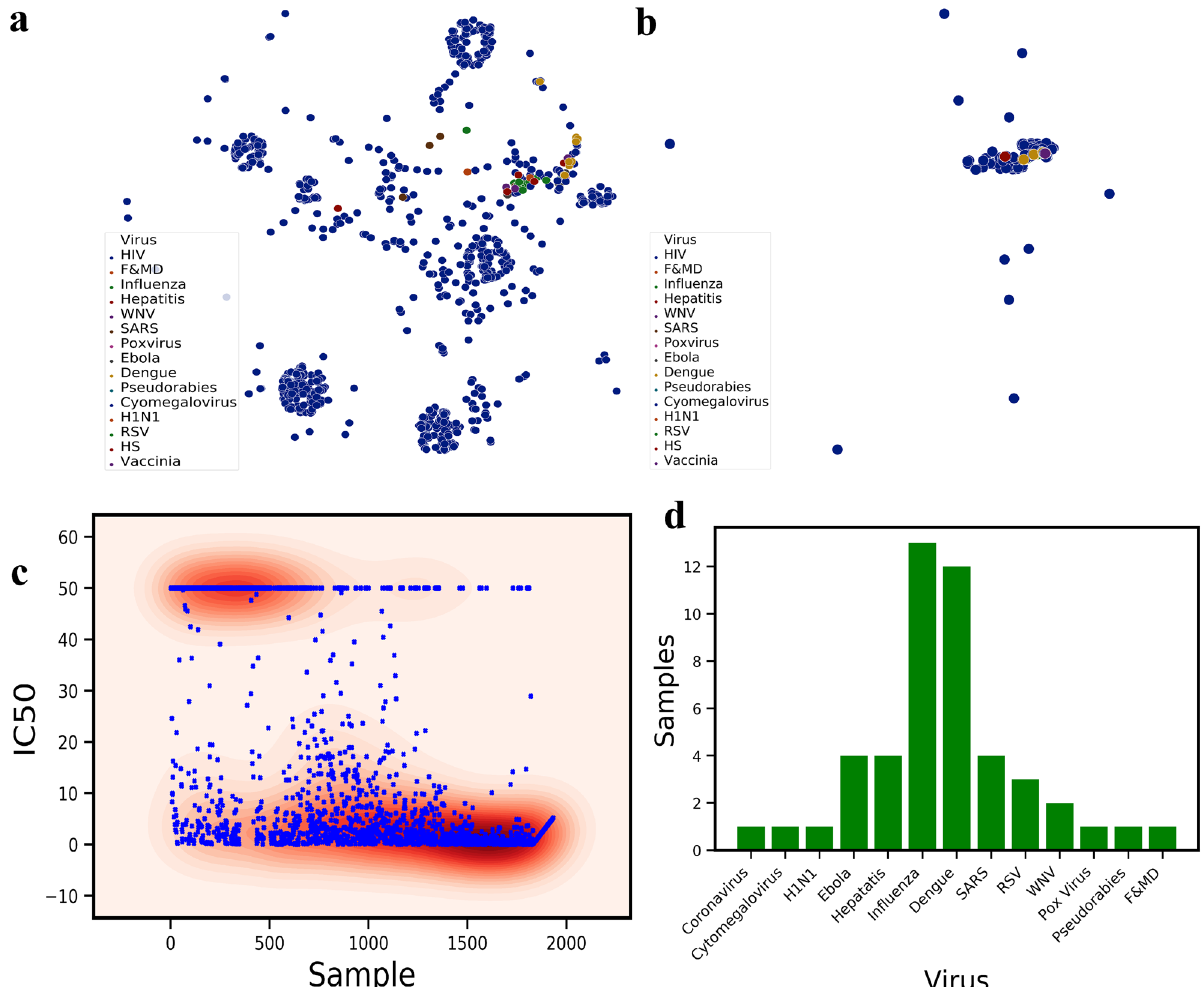
Figure 2. ( a ) t-Distributed Stochastic Neighbor Embedding (t-SNE) of all the viruses epitopes used in the training dataset, revealing biological similarity and diversity of the sequences used in the dataset. ( b ) t-SNE of all the therapeutics antibody sequences used in the training set for variety of different virus types. The majority of the broadly neutralizing antibodies such as 2F5 is clustered at the center of this plot. ( c ) Patient clinical IC50 data obtained from various sources and the distribution of the neutralizing (IC 50 < 10) and Non-neutralizing (IC 50 > 10) samples. ( d ) The number of samples for each virus class except HIV. For HIV, we collected 1883 samples. Influenza and Dengue has 10+